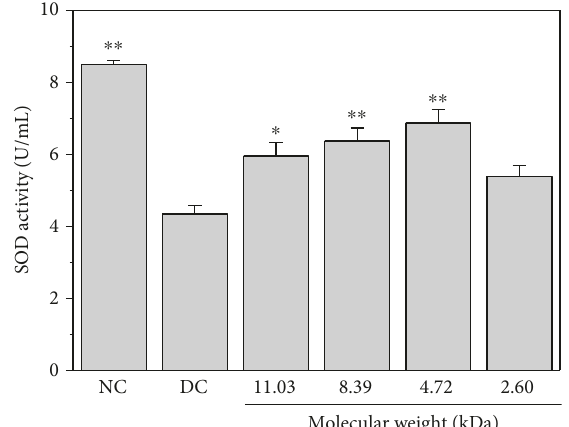
Figure 7: Changes of SOD activity after the damaged HK-2 cells were repaired by APS with di ff erent molecular weights for